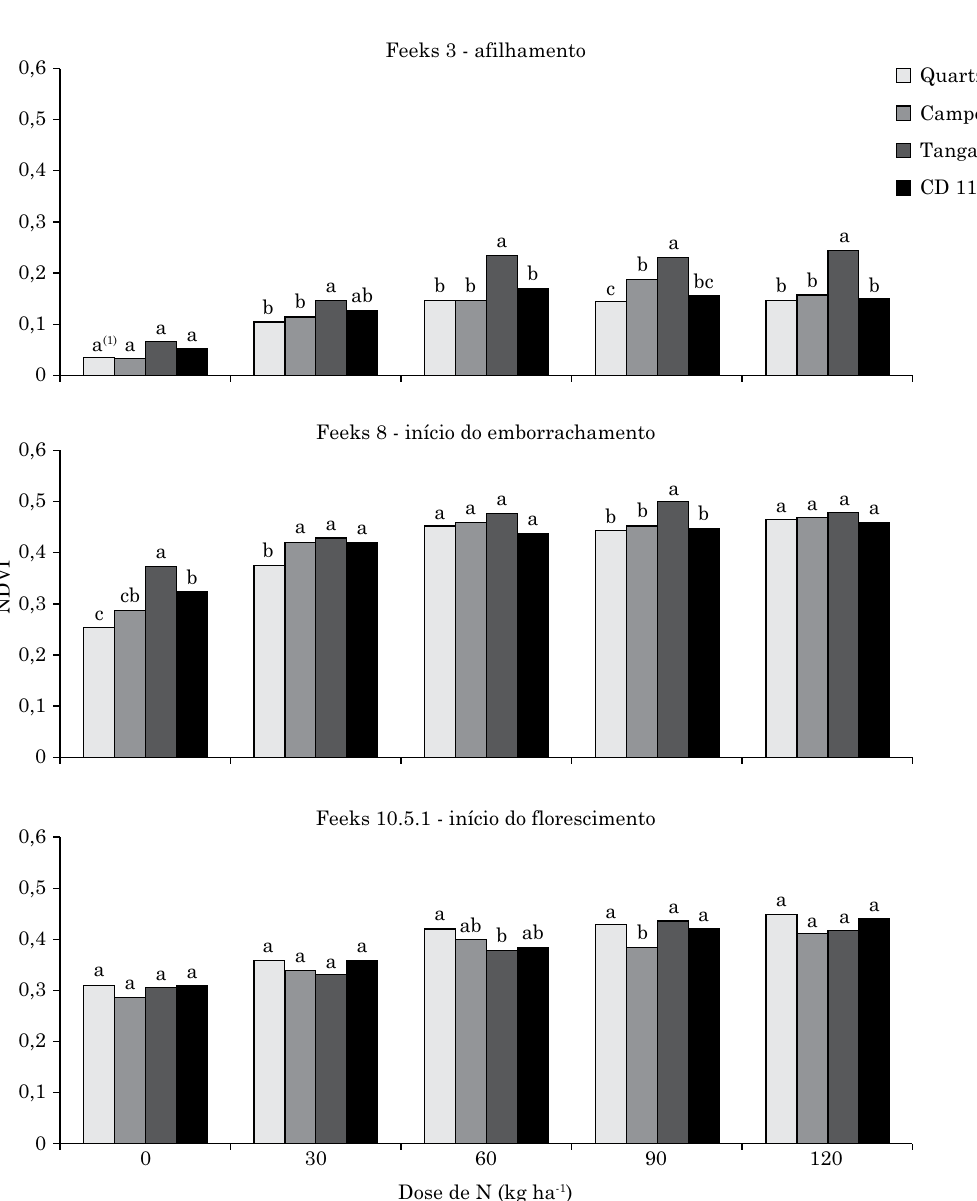
figura 1. Índices de vegetação por diferença normalizada (ndVi) obtidos pelo sensor passivo, das cultivares de trigo em razão das doses de nitrogênio (n), nos distintos estádios fenológicos. letras comparam cultivares para cada dose de n, em cada estádio fenológico, pelo teste tukey a 5